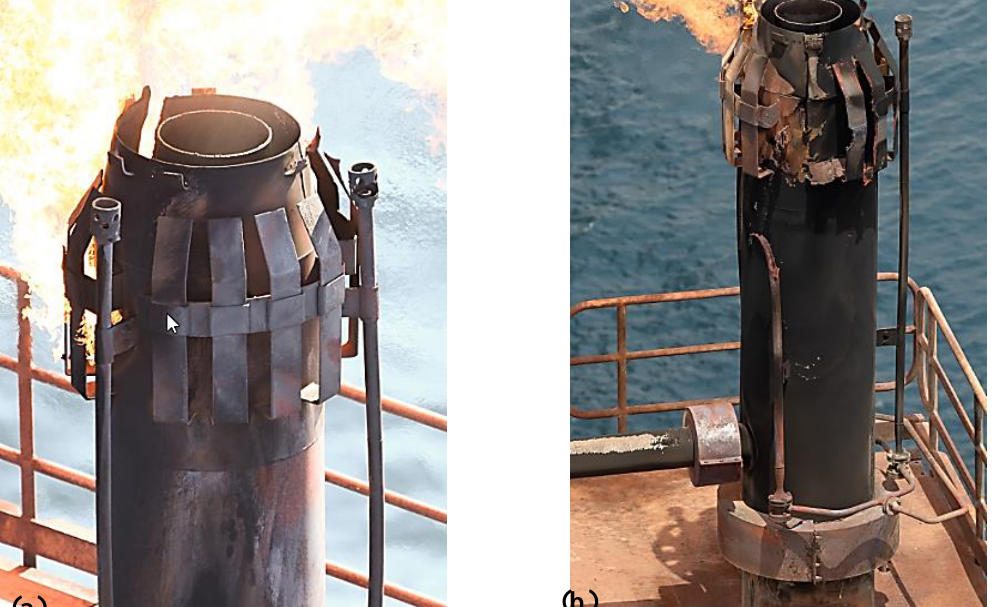
Figure 2. The investigated Gas flare Tip ( a ) Gas fare tip ( b ) Gas flare tip with immature failure .